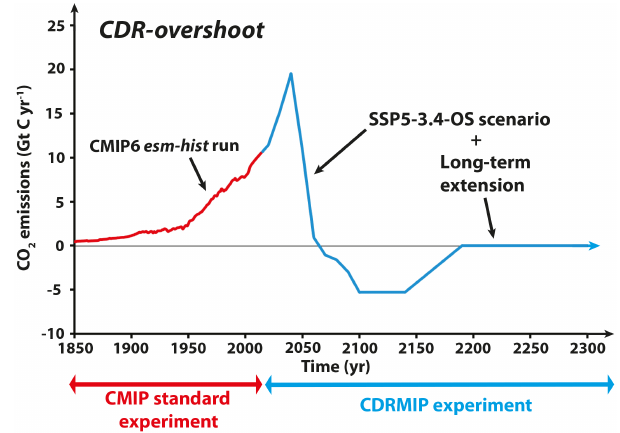
Figure 6. Schematic of the CDRMIP emission-driven SSP5-3.4-OS scenario experimental protocol ( CDR-overshoot ). A CO 2 -emission- driven historical simulation is conducted until the year 2015. Then an emission-driven simulation with SSP5-3.4-OS scenario forcing is conducted. This simulation is extended until the year 2300 using SSP5-3.4-OS scenario long-term extension forcing. Thereafter, runs may continue for as long as computationally possible with constant forcing after the year